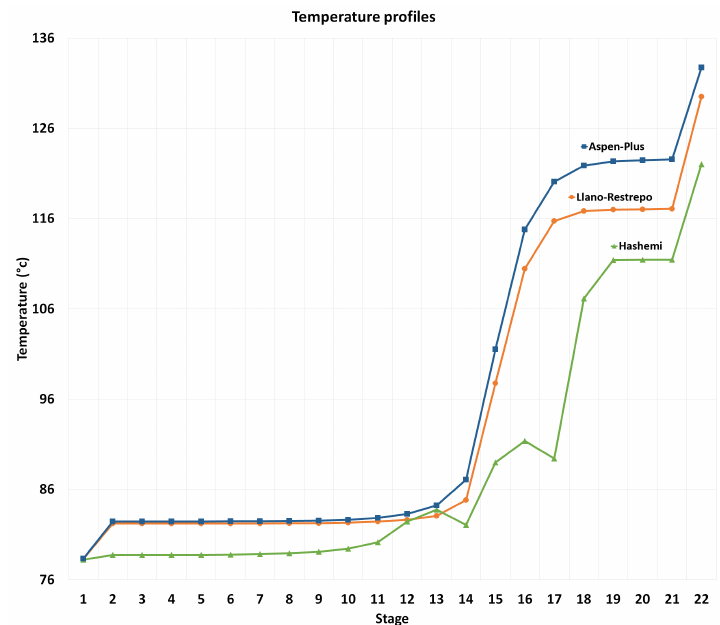
Figure 4. Comparison of the temperature profiles of the saline extractive distillation column simula- tion. Aspen Plus ® vs. Llano − Restrepo et al. and Hashemi et al.